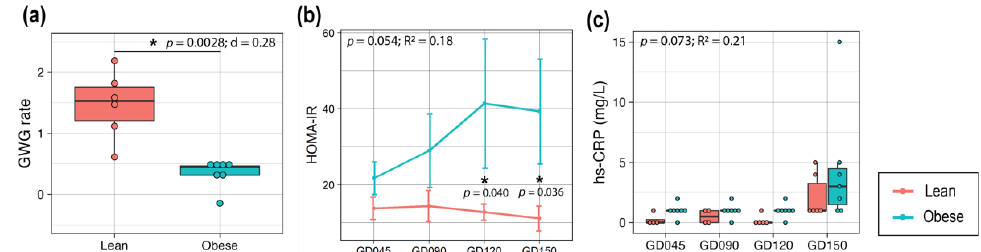
Figure 1. Metabolic characteristics of the Lean and Obese mothers throughout pregnancy. ( a ) GWG rate between the last day before conception and delivery. t -tests were used to test for group differences in the overall GWG rate. ( b ) Line plot representing the mean ± SE of HOMA-IR values throughout pregnancy. ( c ) Plasma hs-CRP level. For ( b , c ), a linear mixed-effects model was fit followed by ANOVA to test for group differences in HOMA-IR and hs-CRP, and pairwise comparisons were done as post hoc tests using the estimated marginal means. For box plots ( a , c ), each dot represents data from an individual animal. Top and bottom of the boxes represent the 25th and 75th percentiles respectively; the middle line represents the median; and the top and bottom whiskers represent maximum and minimum values. Points outside of the whiskers represent outliers. Statistical significance is indicated with “*”. The red and blue lines correspond to the Lean and Obese groups, respectively. Sample size: Lean = 6, Obese = 7. Abbreviations: d or R 2 , effect size measurements; GWG, gestational weight gain; GD, gestational day; HOMA-IR, homeostatic model assessment for insulin resistance; SE, standard error, hs-CRP, high-sensitivity C-reactive protein.